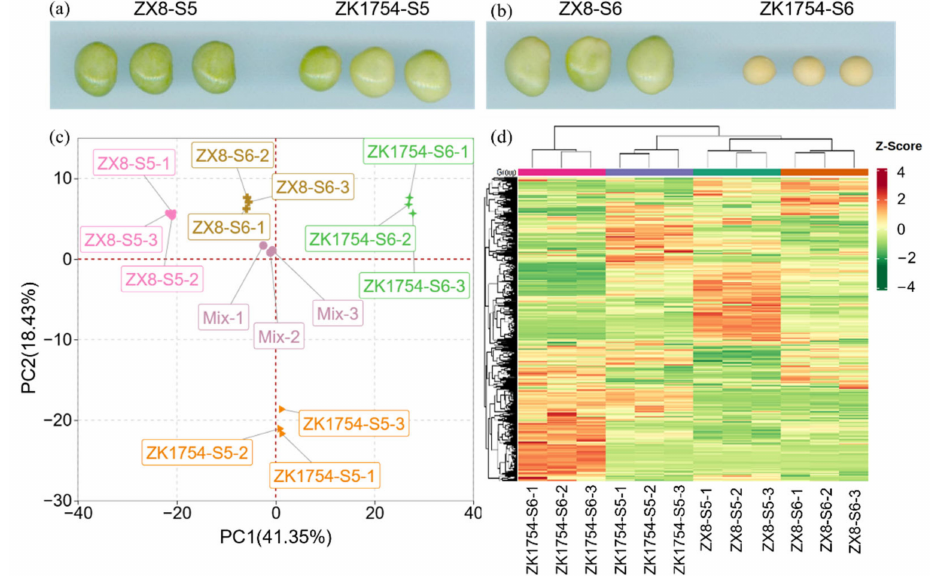
Figure 1. Metabolic changes in soybean grain at different developmental stages of ZX8 and ZK1754. ( a , b ) Photographs of grains at two stages of ZX8 (ZX8-S5, ZX8-S6) and of ZK1754 (ZK1754-S5, ZK1754-S6). ( c ) Metabolite principal component analysis (PCA), ‘mix’ was the pooled samples of each group, and three biological replicates were used for metabolite analysis. ( d ) Clustered heatmap of all metabolites. Each sample is represented by a column, each metabolite is represented by a row, the content of each metabolite is represented by a bar with a specific color, and the up- and down-regulated metabolites are represented by different degrees of red and green, respectively, with three biological replicates for metabolite